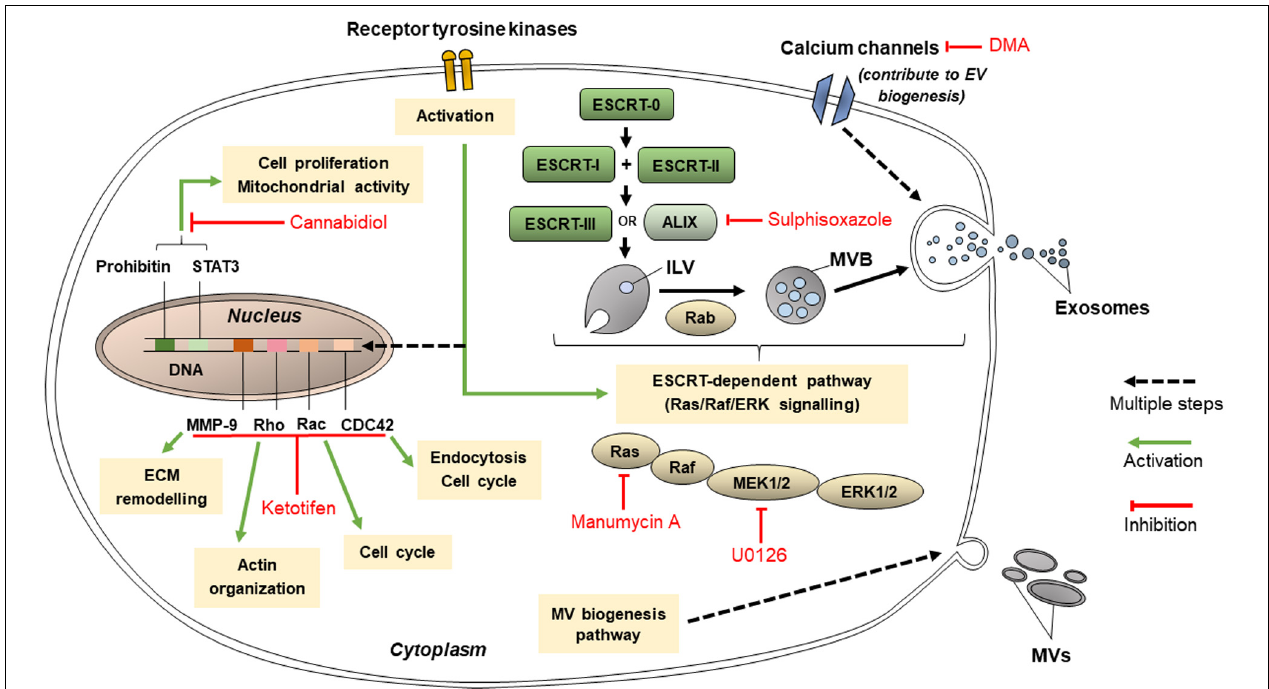
FIGURE 4 | Pathways that targeted by cannabidiol, ketotifen, manumycin A, U0126, sulphisoxazole, and dimethyl amiloride (DMA) for inhibition of EV